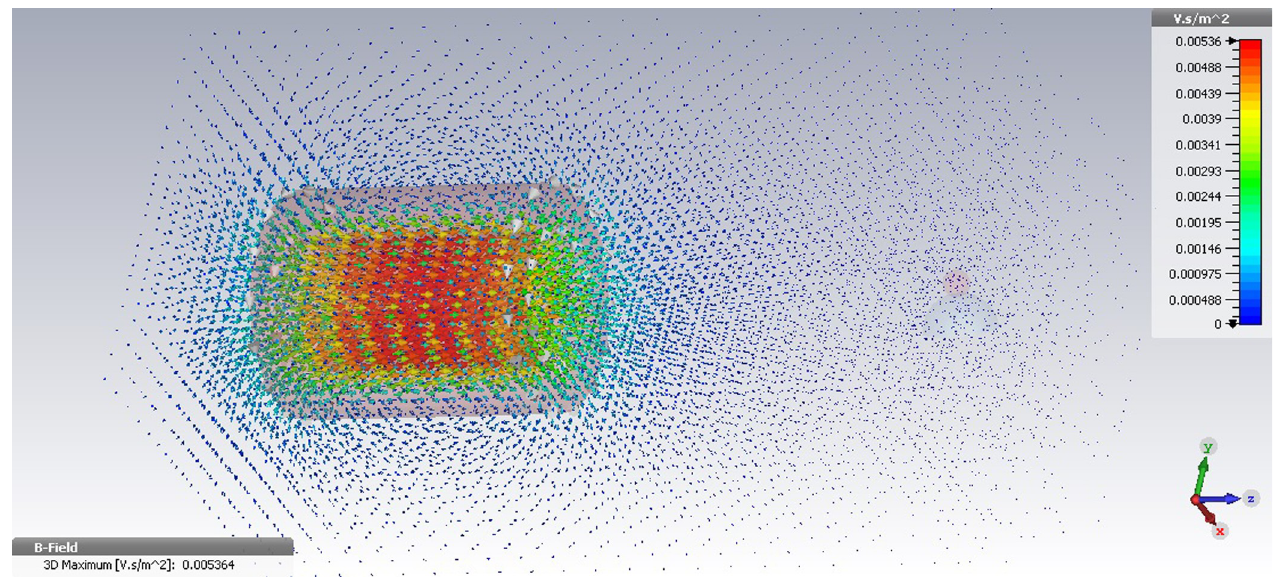
Fig 2. The 3D image of magnetic field simulation for the cylindrical coil under the applied current 3000 mA using CST.